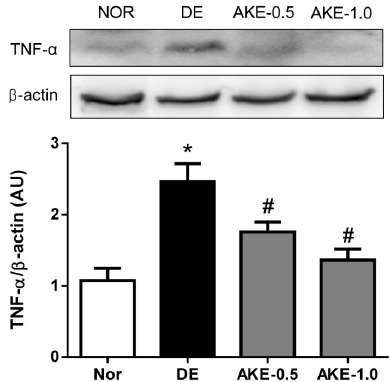
Figure 6. Effects of AKE on the expression level of TNF ‐α in corneal and conjunctival tissues. The expression of TNF ‐α was assessed by Western blot analysis. Quantification of relative protein levels, compared with β‐ actin (a loading control). The values in the bar graph represent the mean ± SE, n = 5. * p < 0.05 vs. normal mice, # p < 0.05 vs. vehicle ‐ treated dry eye mice.